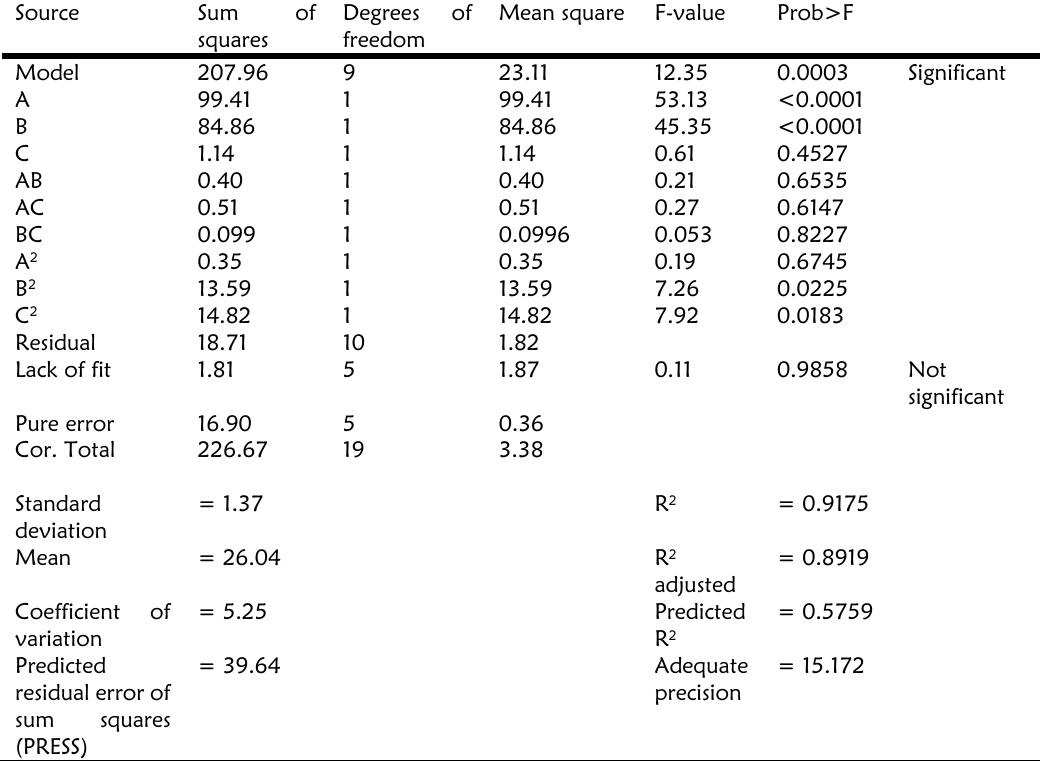
Table 5: ANOVA for recast layer (before eliminating)